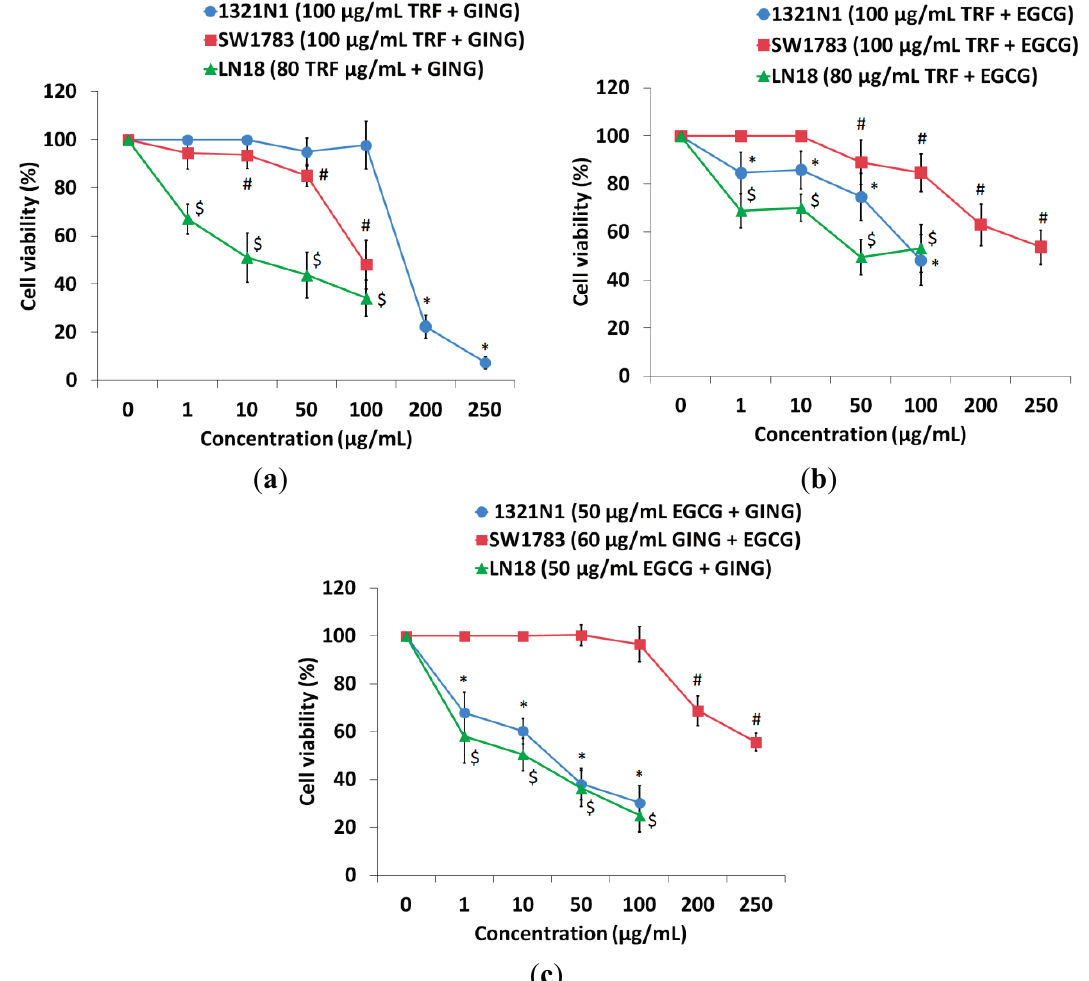
Figure 2. Combined treatment of ( a ) TRF with GING, ( b ) TRF with EGCG and ( c ) EGCG with GING on 1321N1, SW1783 and LN18 for 24 h. The cell survival test was determined by the MTS assay. Data are presented as the means ± SD, n =